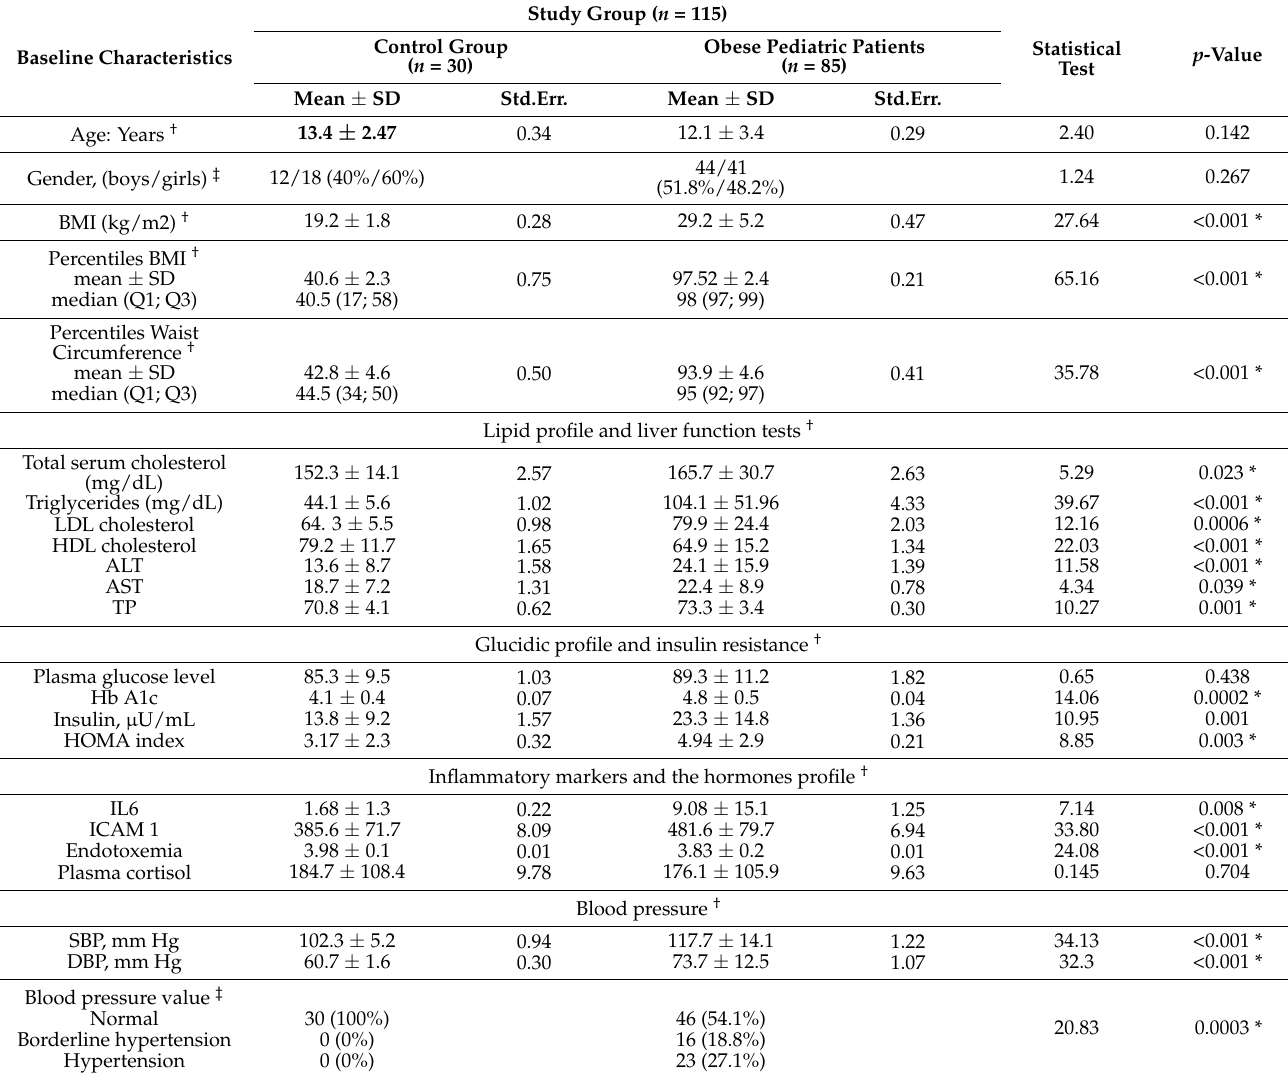
Table 1. Comparison of clinical and biochemical parameters between the group of obese pediatric patients and the control